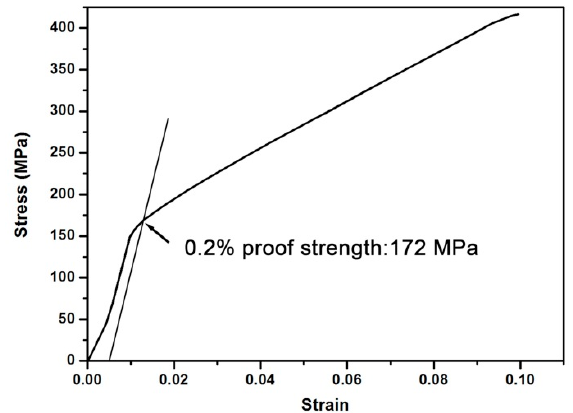
Figure 1. The stress – strain diagram of the supercooled austenite (austenitized at 1200 °C) at 330